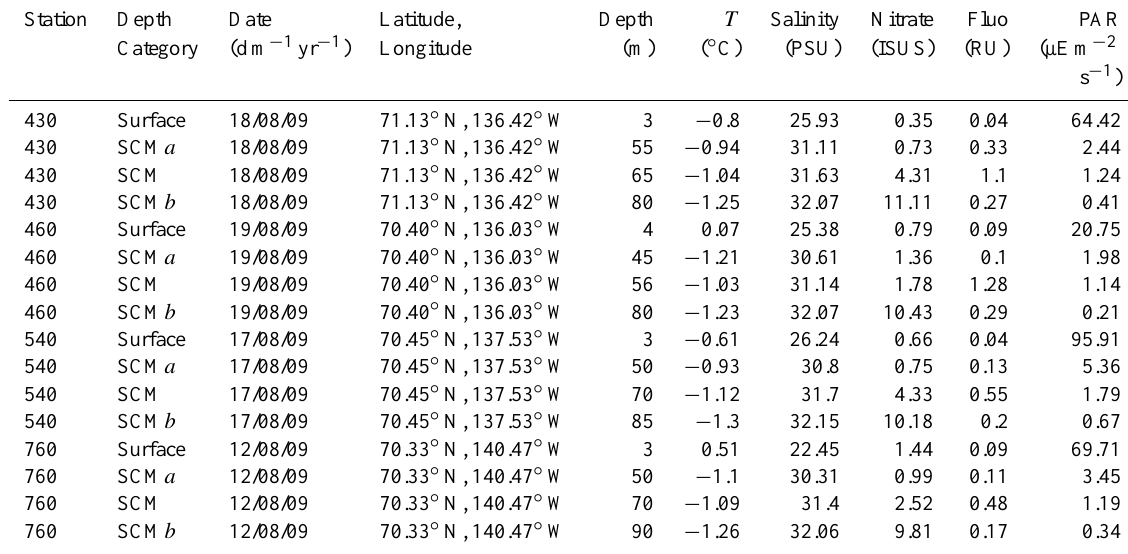
Table 1. Metadata for the Beaufort Sea stations and depths from which eukaryotic microbial communities were sampled (Table S1 lists additional